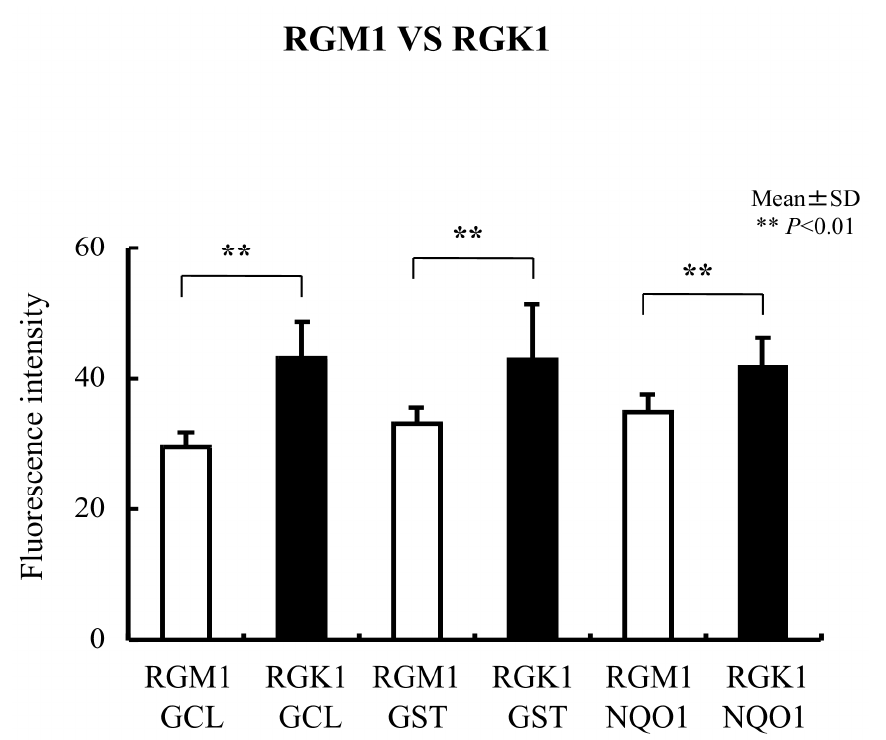
Figure 4. Immunohistochemical staining with anti-GCL, anti-GST, and anti-NQO1 antibodies in RGM1 and RGK1 cell lines was performed. The fluorescence intensity for GCL, GST, and NQO1 was significantly higher in RGK1 cells compared with that in RGM1 cells. Bar: mean ± S.D.; t -test. ** p < 0.01.